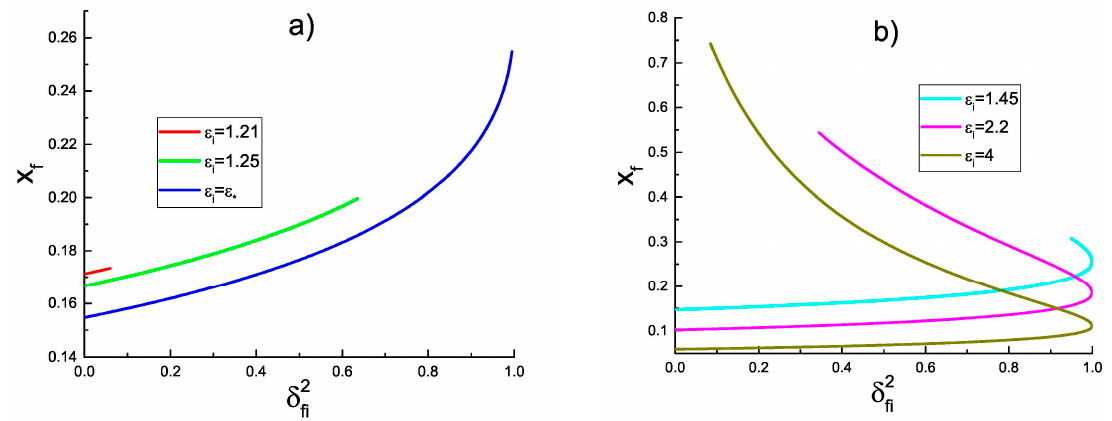
for different values of energy fi